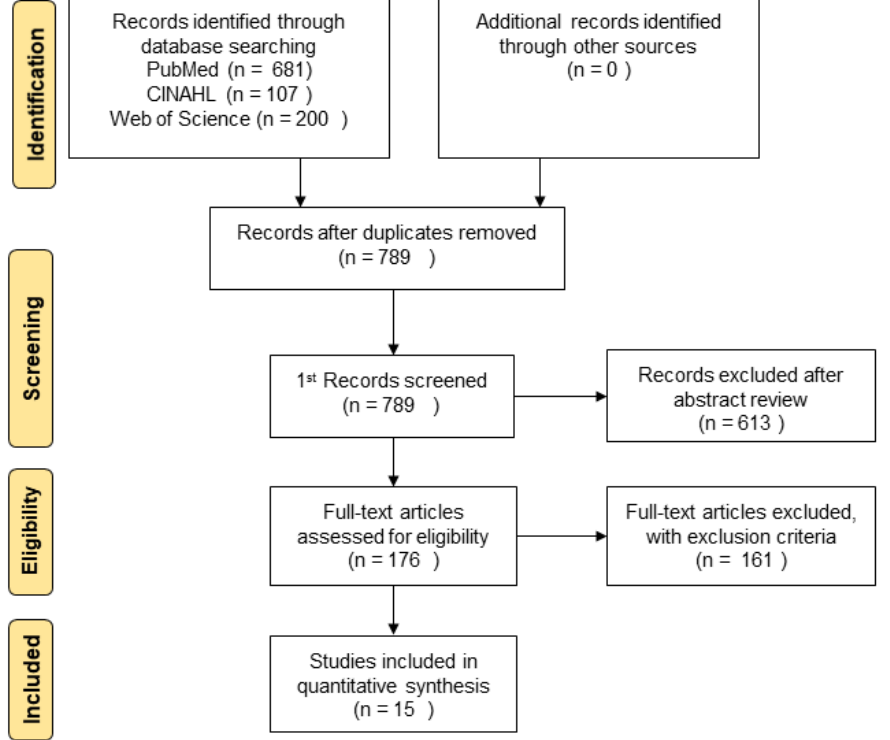
Figure 1. Flow diagram for study